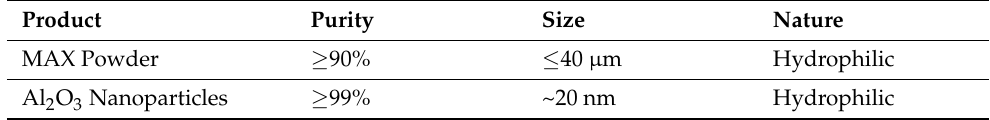
Table 1. Specifications of the MAX powder and Al 2 O 3